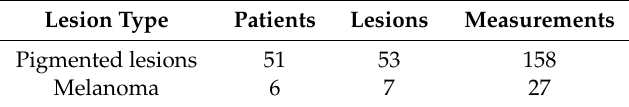
Table 2. Clinical data summary.